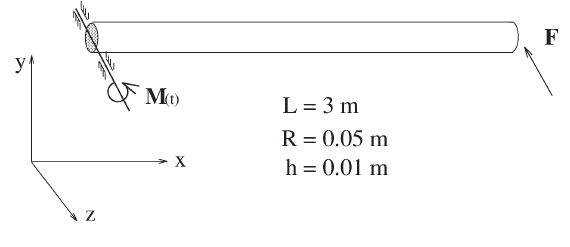
Fig. 3. Rotation of flexible pipe. Fig. 5. Rotation of flexible pipe with end force.